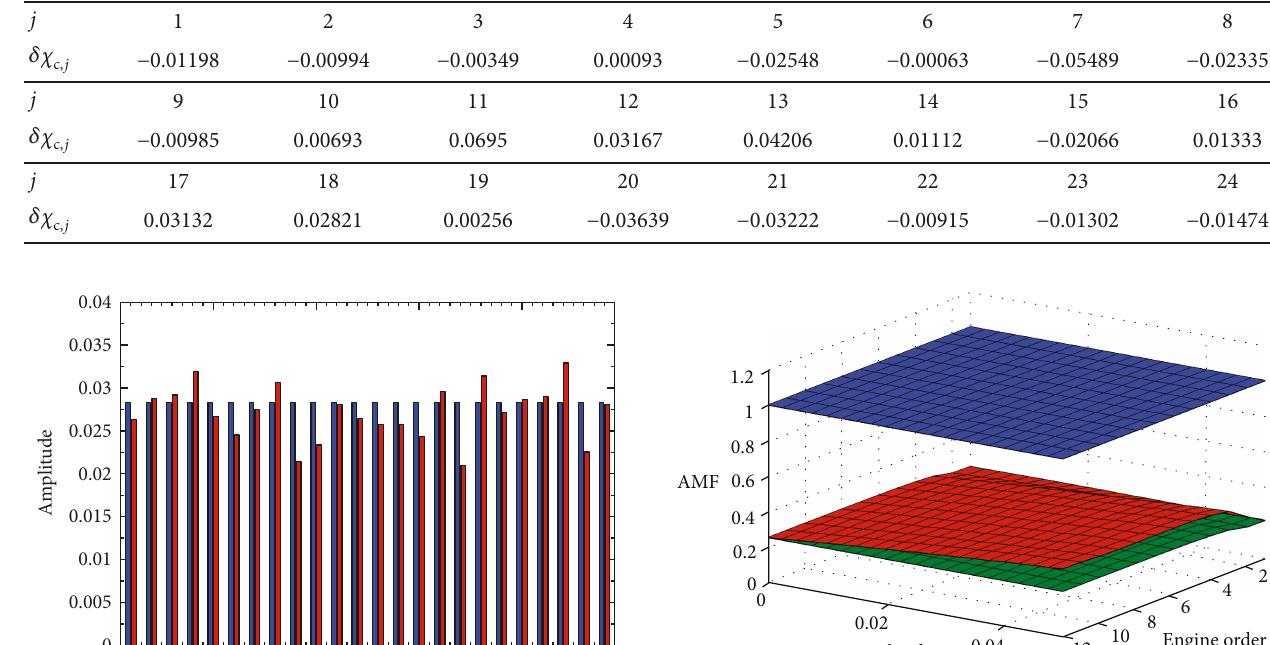
Table 5: A mistuned sample of the capacitance ratio.